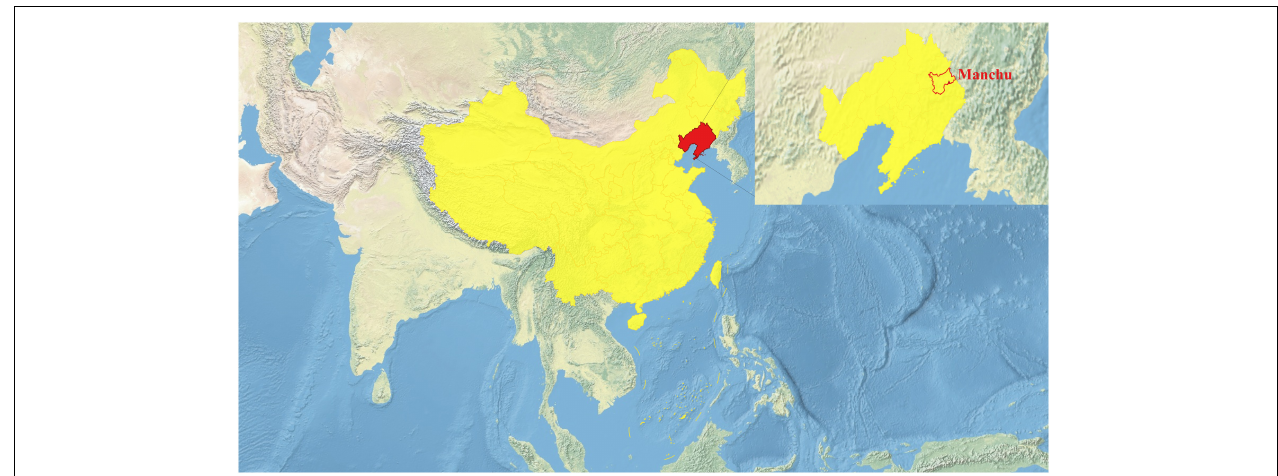
FIGURE 1 | Map of the sampling location for this study